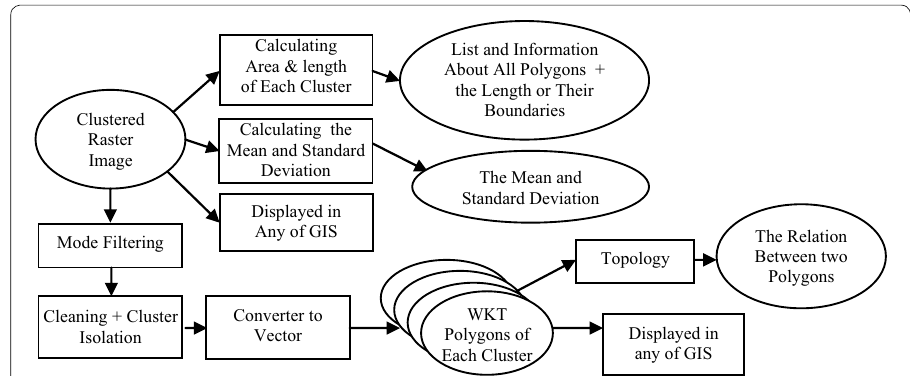
Fig. 7 Phase-3 filtering and topology